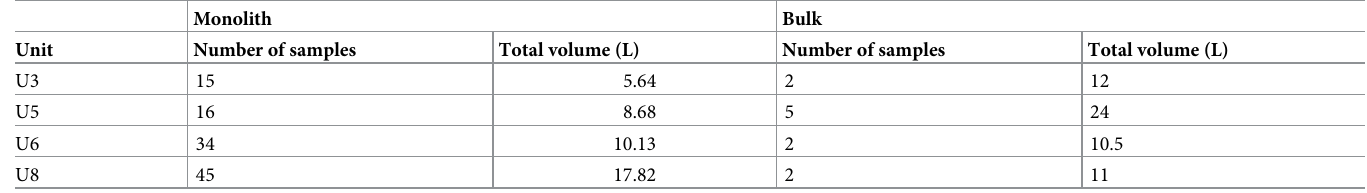
Table 2. Number and volume of the different monolith and bulk samples of units U3, U5, U6 and U8 serving for the analyses. Monolith Bulk Unit Number of samples Total volume (L) Number of